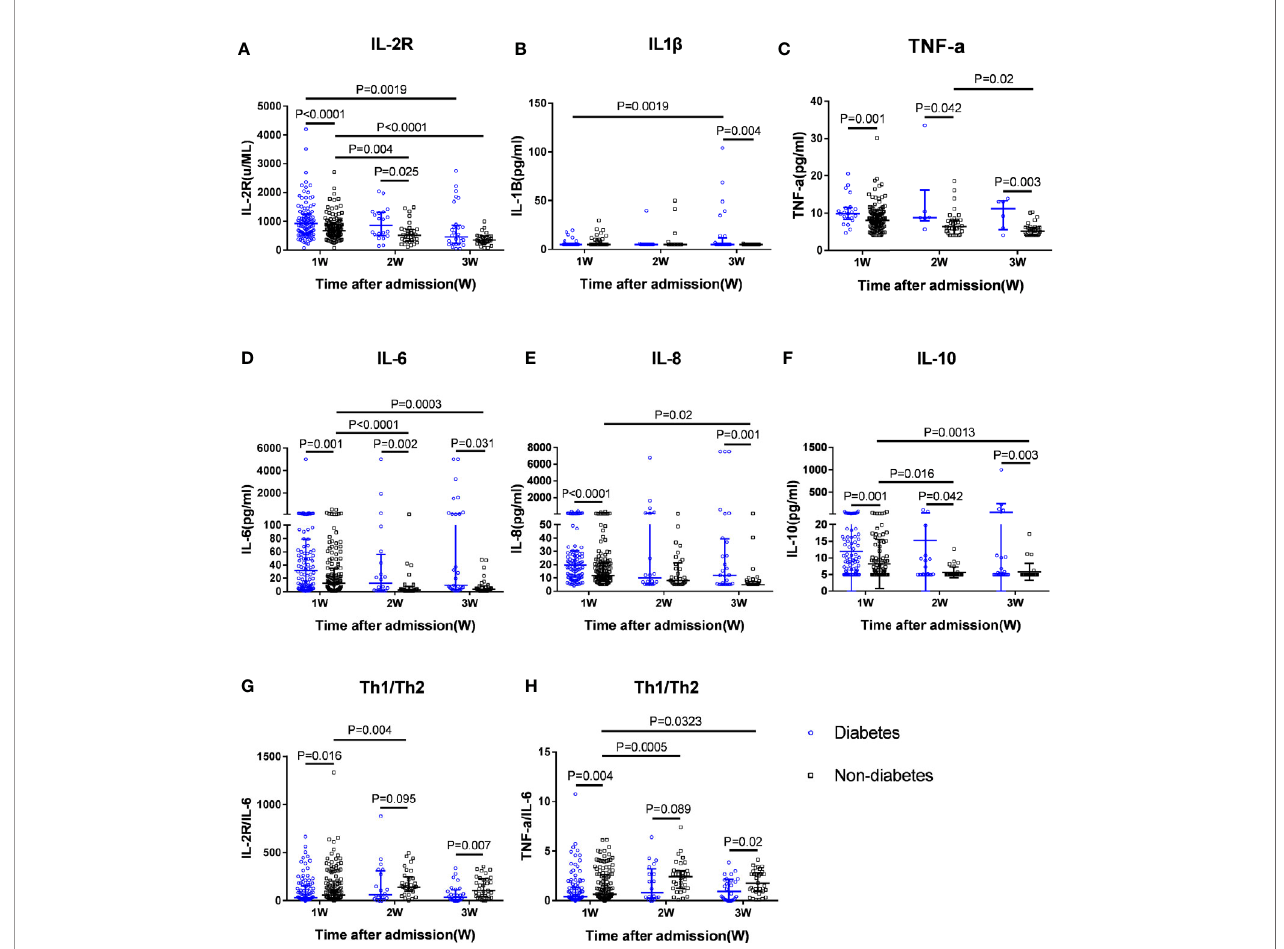
FIGURE 2 | Dynamic serum cytokine levels and Th1/Th2 ratios in diabetic patients and non-diabetic patients. Dynamic changes in Th1 cytokines including IL-2R (A) , IL-1 b (B) , and TNF- a (C) ; Th2 cytokines, including IL-6 (D) , IL-8 (E) , and IL-10 (F) , and ratios of IL-2R/IL-6 (G) and TNF- a /IL-6 (H) representing the Th1/Th2 ratios from week 1 to week 3 after admission in patients with T2DM and patients without T2DM with COVID-19